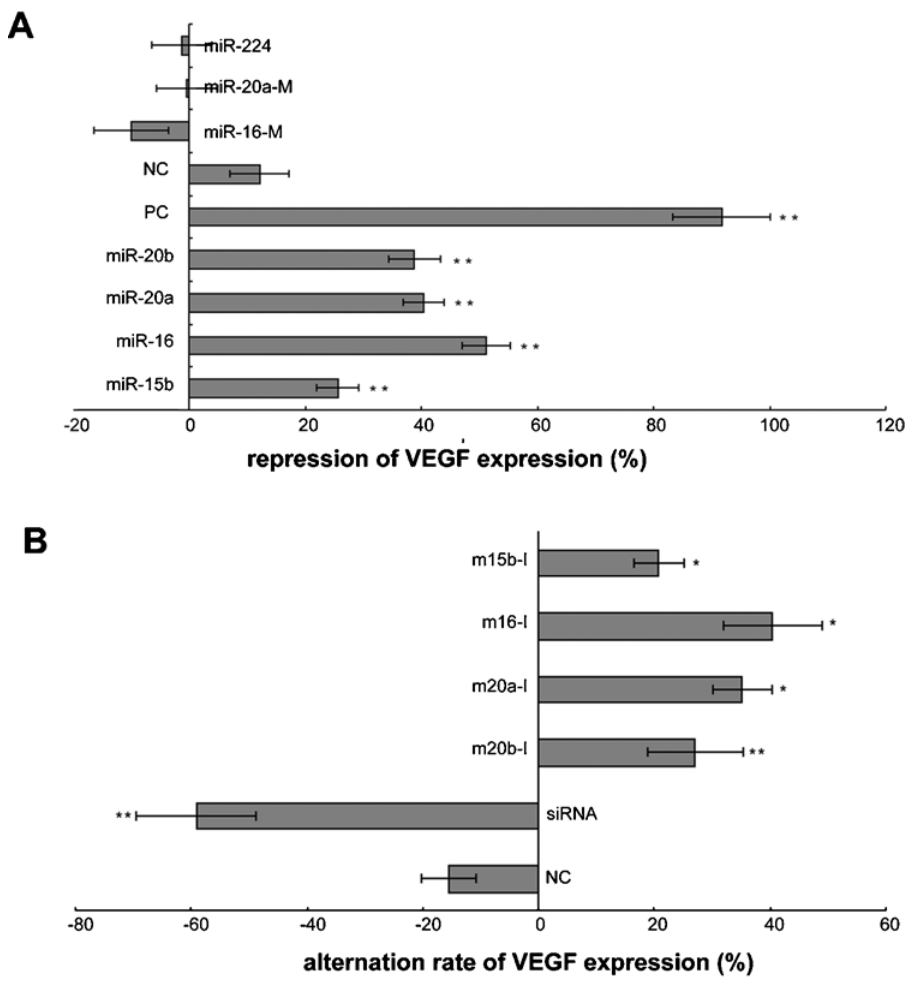
Figure 3. Validation of the repressive effect of putative miRNA regulators on VEGF expression in CNE cells. (A) Transient overexpression of miRNAs in hypoxia-induced CNE cells. The effect of miR-15b, miR-16, miR-20a , and miR-20b on VEGF expression was tested in CNE cells by transfection of the cells with siRNA duplexes homologous in sequence to the miRNAs. ELISA was used to detect VEGF expression levels. The controls consist of one positive control: VEGF-siRNA (PC), and four negative controls: miR-224 , mutated miR-16 , and miR-20a ( miR-16M, miR-20aM ), and a random sequence (NC). (B) Transfection of miRNA inhibitors in hypoxia non-induced CNE cells. CNE cells were transfected with inhibitors of miR-15b, miR-16, miR-20a , and miR-20b . siRNA against VEGF was used as positive control. ELISA was used to detect the change in VEGF expression levels after endogenous miR-15b, miR-16, miR-20a , and miR-20b were inhibited. *, p , 0.05; **, p , 0.01. NC: negative control; PC: positive control.